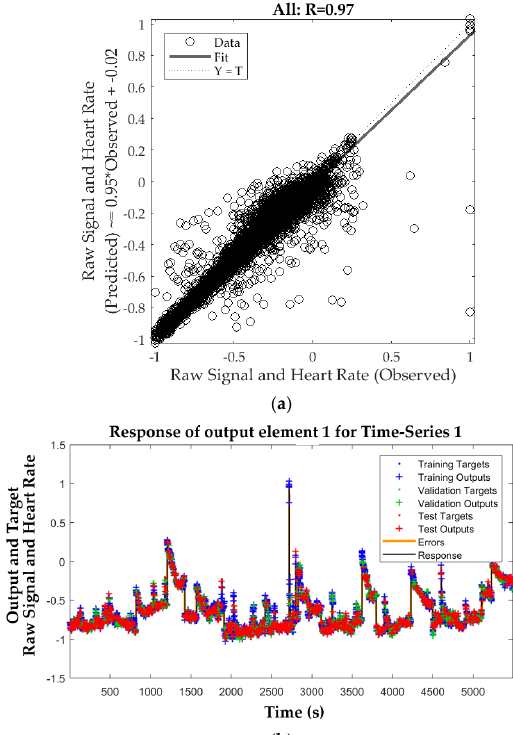
Figure 8. Response from the shallow neural network time-series (SNNTS) model (Model 2) where: ( a ) shows the regression model with an overall high correlation (R = 0.97), where the x-axis